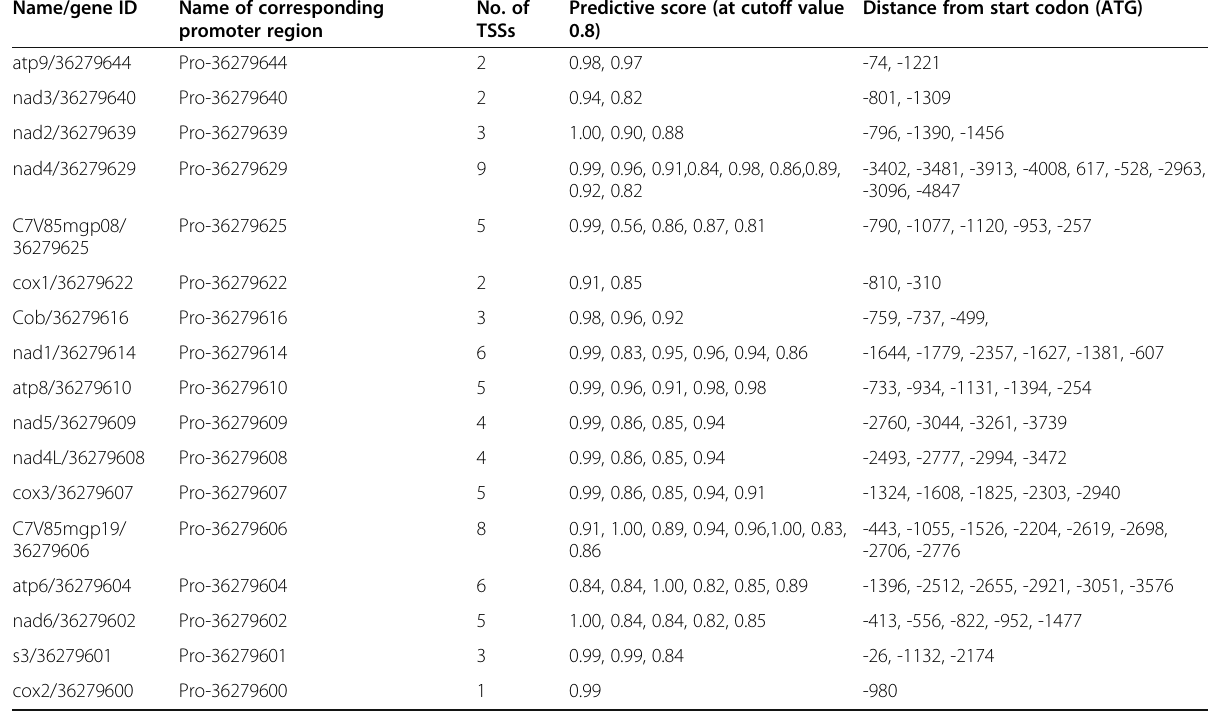
Table 1 Identified TSSs and predictive score value for Trametes hirsuta strain 072 Name/gene ID